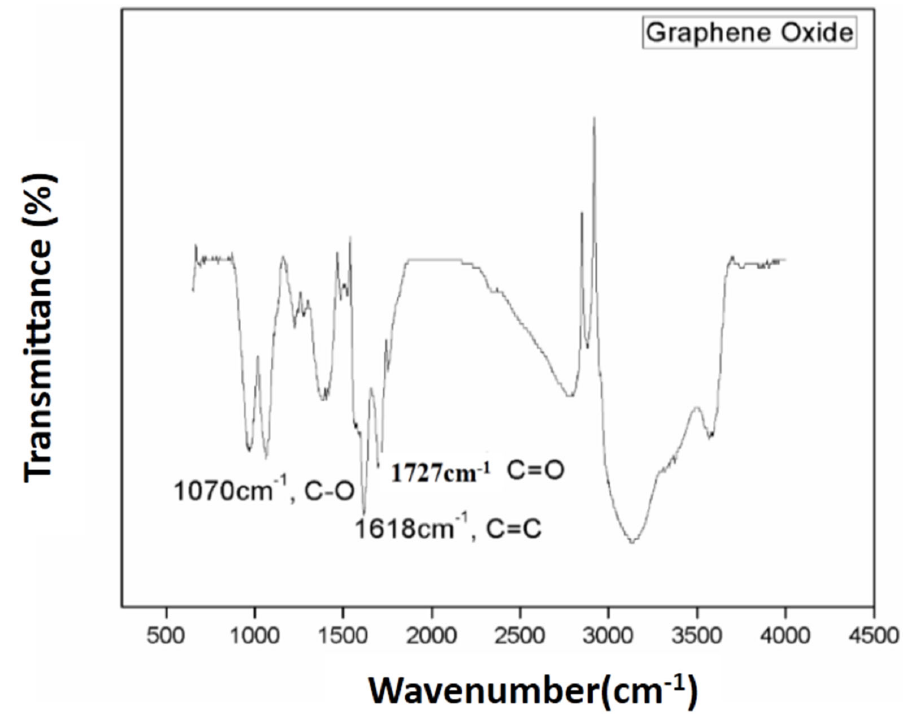
Figure 1. FTIR spectrum of graphene oxide.